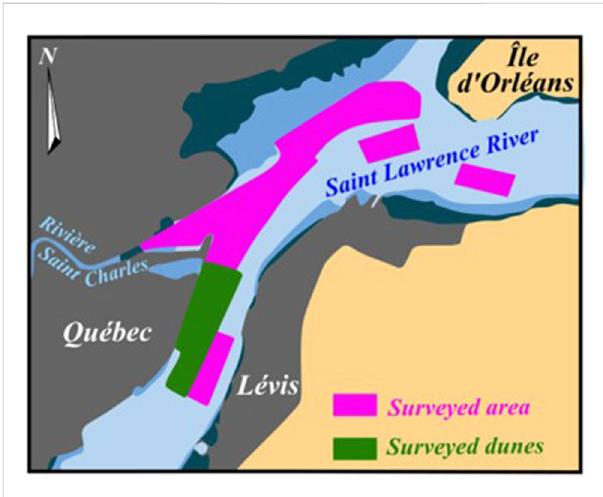
FIGURE 2 Surface covered on the data acquisition in Summer of 2022 on the fl uvial estuary of the Saint-Lawrence